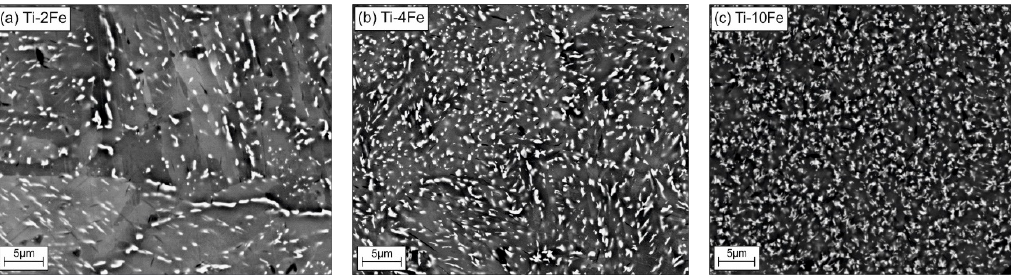
Figure 1. Initial microstructures of samples Ti-2Fe ( a ), Ti-4Fe ( b ), and Ti-10Fe ( c ) annealed at 470 °C for 4000 h. The white grains belong to TiFe, the gray areas to α -Ti. Table 1. Comparison of the phase fractions in the samples annealed at 470 °C for 4000 h, which were determined from the X-ray diffraction (XRD) measurements and calculated using the thermodynamic description of the binary Ti–Fe system by application of the lever rule. All of the phase amounts are given in wt.%. The uncertainty of the XRD phase analysis utilizing Rietveld refinement falls generally within a range of 1 % to 3 %.